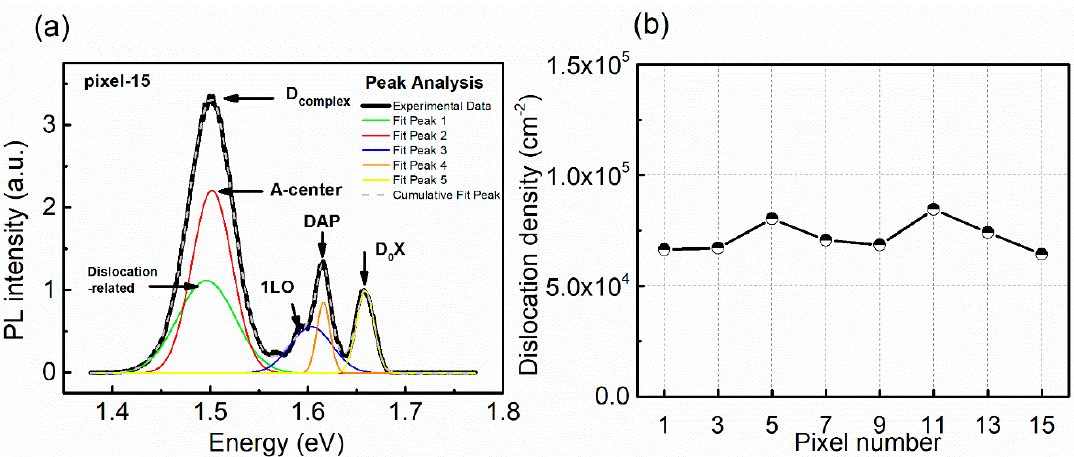
Figure 5. ( a ) Multi-Gaussian fitting for the typical PL spectra using pixel-15 as an example; ( b ) statistical results of the dislocation density in the typical pixel regions.